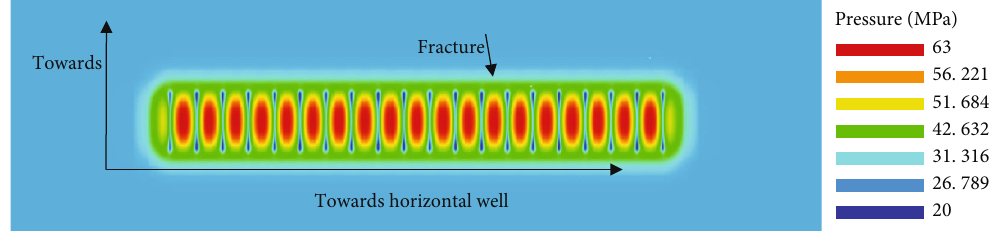
Figure 8: Isoline cloud fi gure of pressure distribution along fracture direction of fracturing fl uid fl ows back for 5 days in a multistage fractured-horizontal well.